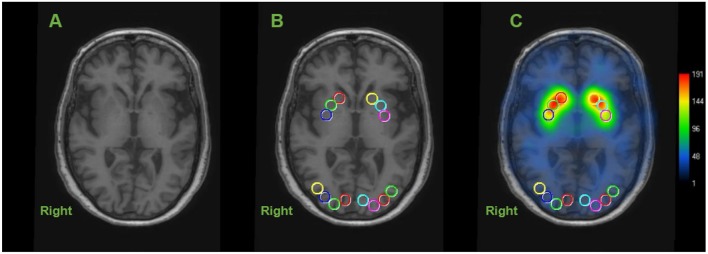
Representative image of regions of interest (ROIs) in dopamine transporter (DAT) image. Circular ROIs were manually placed 10 mm in diameter, in each hemisphere on the structural MRI for the caudate nucleus (CN), anterior putamen (AP) and posterior putamen (PP) and 8 on the occipital cortex as the reference region. Calculating each specific activity with DAT binding is estimated by the striatal-to-occipital ratio, defined as (striatum—occipital)/occipital counts. (A) Axial section of structural MRI (3-dimensional T1 weight image). (B) ROIs placed on an axial slice of MRI. (C) [123I]FP-CIT SPECT image overlaid onto the coregistered MRI.